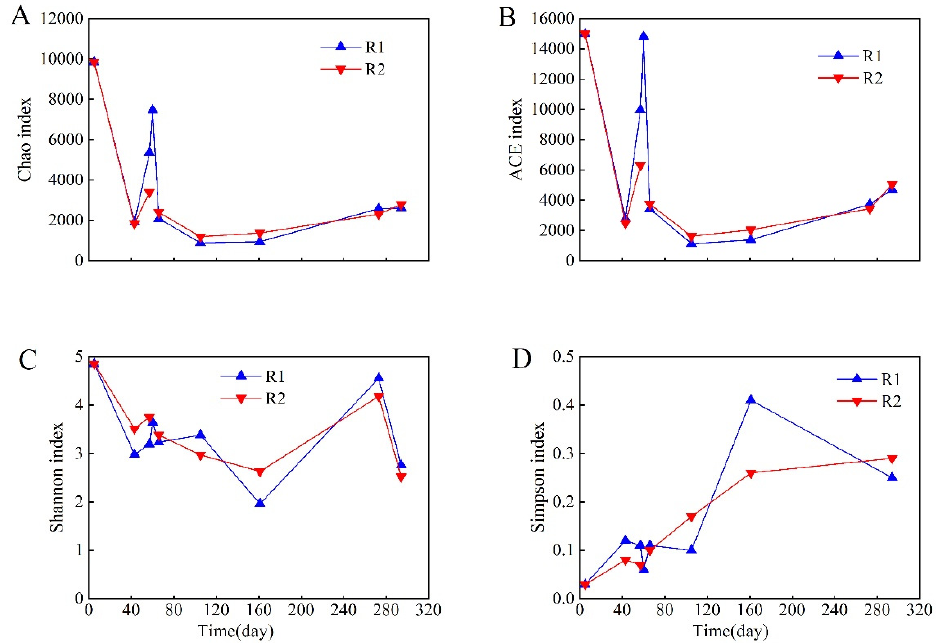
Figure 6. Richness and diversity indices of microbial populations in sewage sludge over the entire operating period in R1 and R2. ( A ) Chao1; ( B ) ACE; ( C ) Shannon; ( D ) Simpson. operating period in R1 and R2. ( A ) Chao1; ( B ) ACE; ( C ) Shannon; ( D )